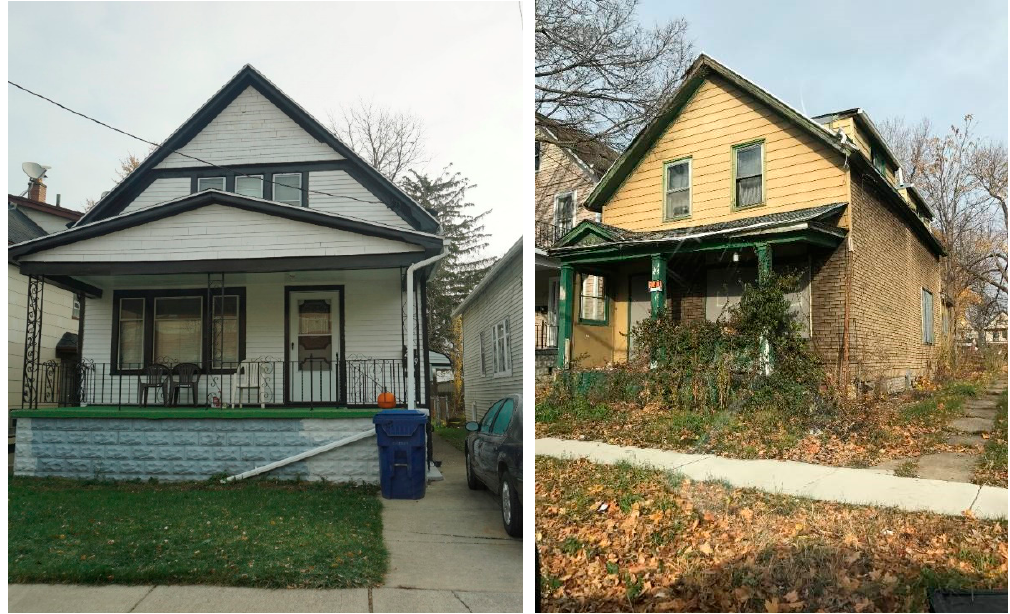
Figure 9. (a) An occupied house in Buffalo, NY. (b) A vacant house in Buffalo, NY. Photos were taken in 2016 by Shengyuan